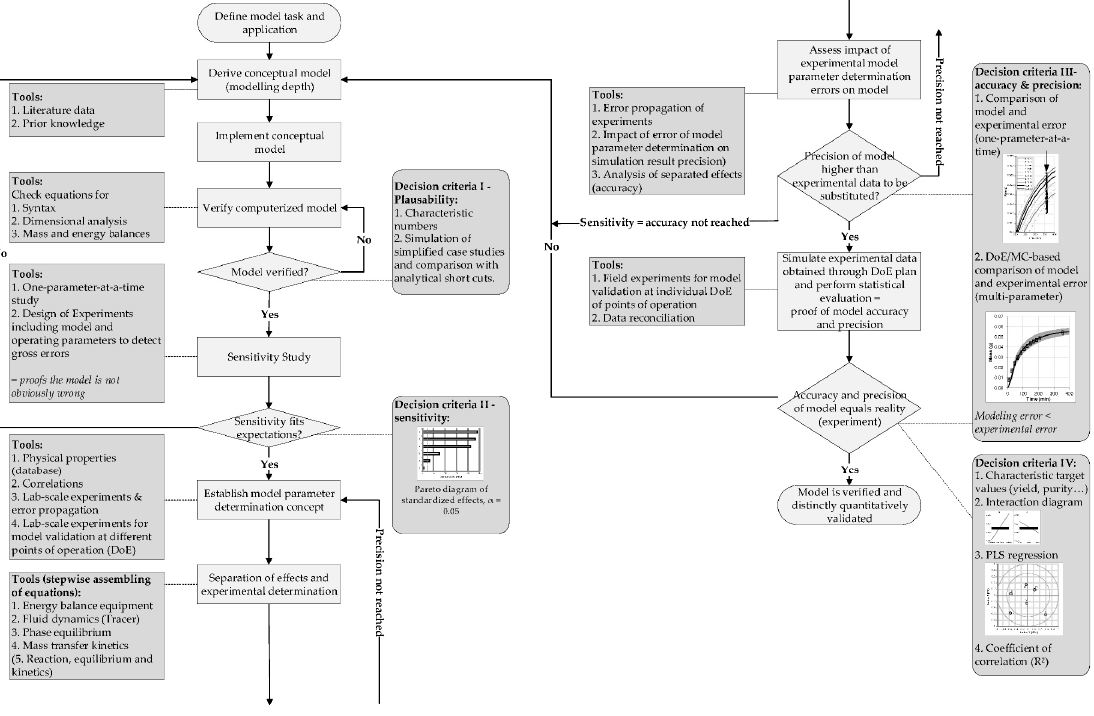
Figure 3. Process and model development workflow. Adapted from [33].